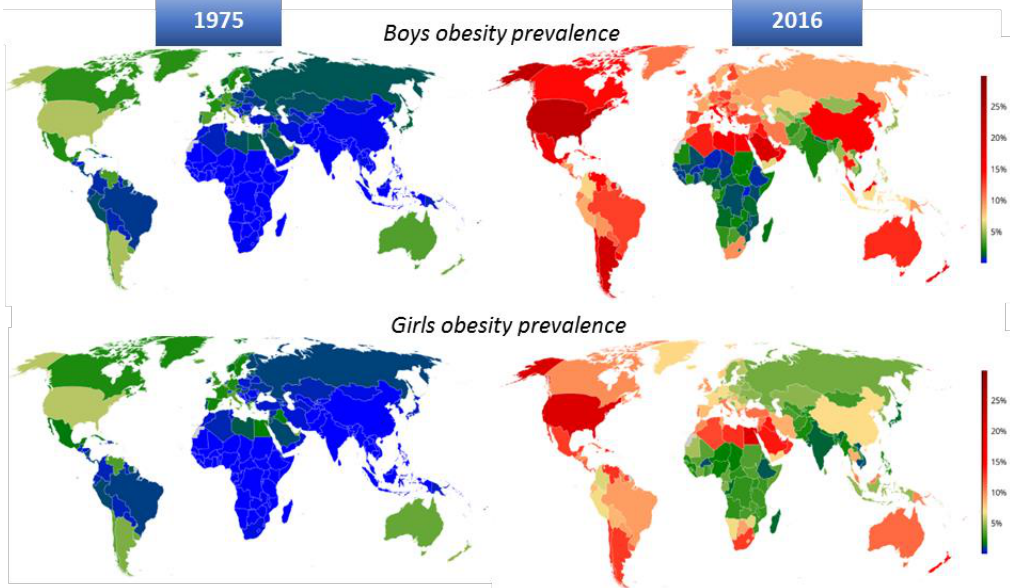
Figure A1. Average Obesity prevalence by club membership. Source: NCD-RisC [48].